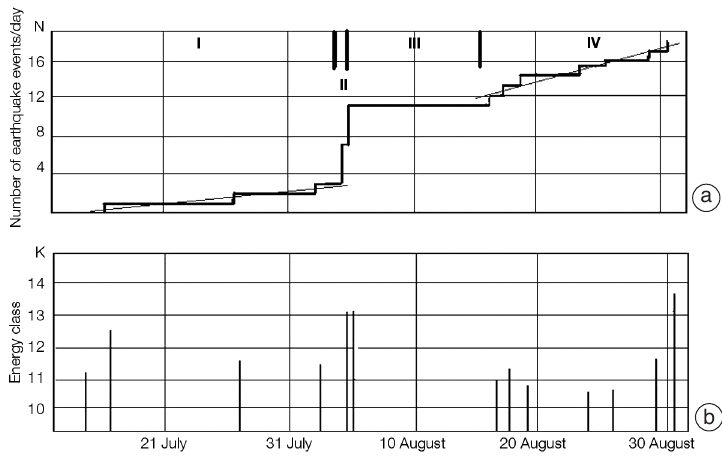
Fig. 6a,b. Events of earthquakes a) with energy class K ≥ 10.5 per a day; b) maximal energy